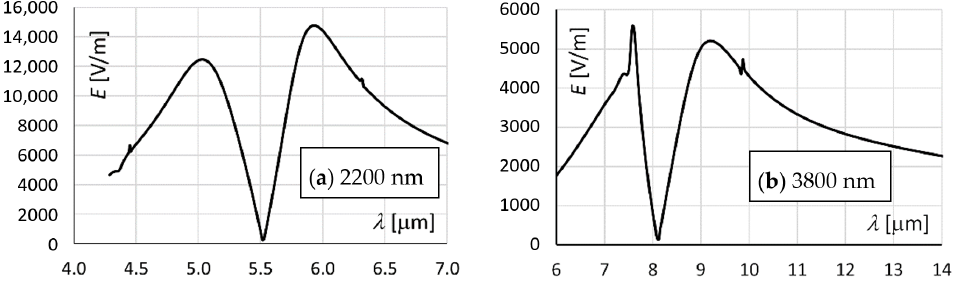
Figure 3. Electric field strength on the edge of the ( a ) 2200 nm and ( b ) 3800 nm slit complementary dipole structures.